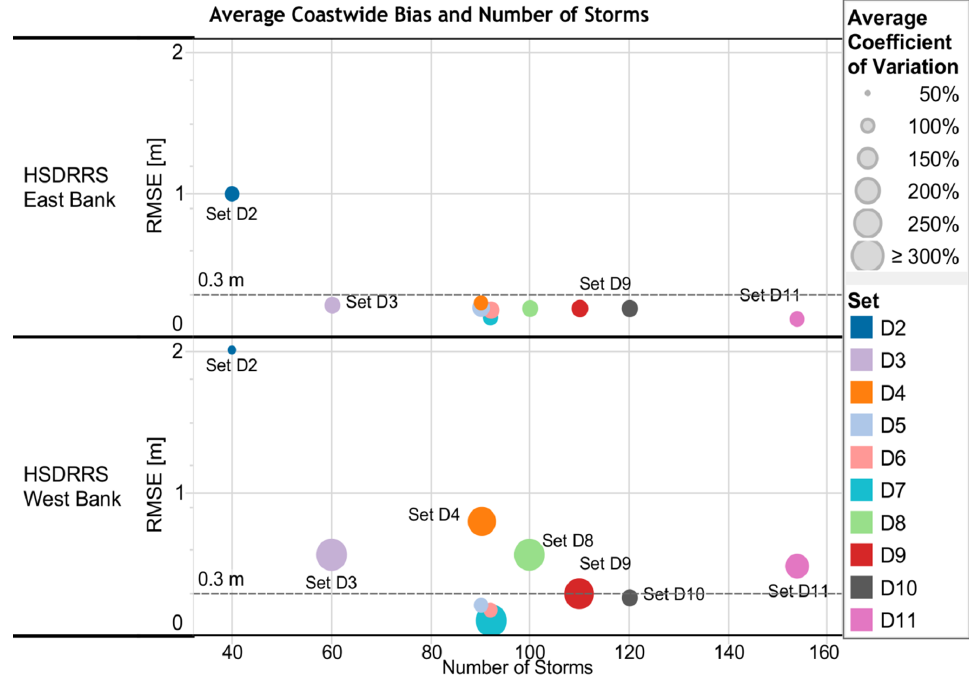
Figure 9. Average bias and variation, 500 ‐ year flood depths, east and west banks of the Greater New Orleans Hurricane Storm Damage and Risk Reduction System. Orleans Hurricane Storm Damage and Risk Reduction